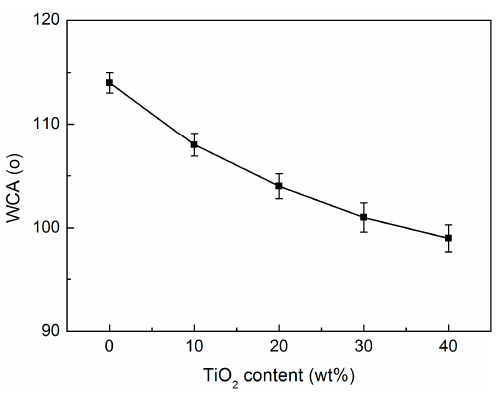
Figure 7. Water contact angle (WCA) of the PP/TiO 2 composite membranes as function of TiO 2 content.